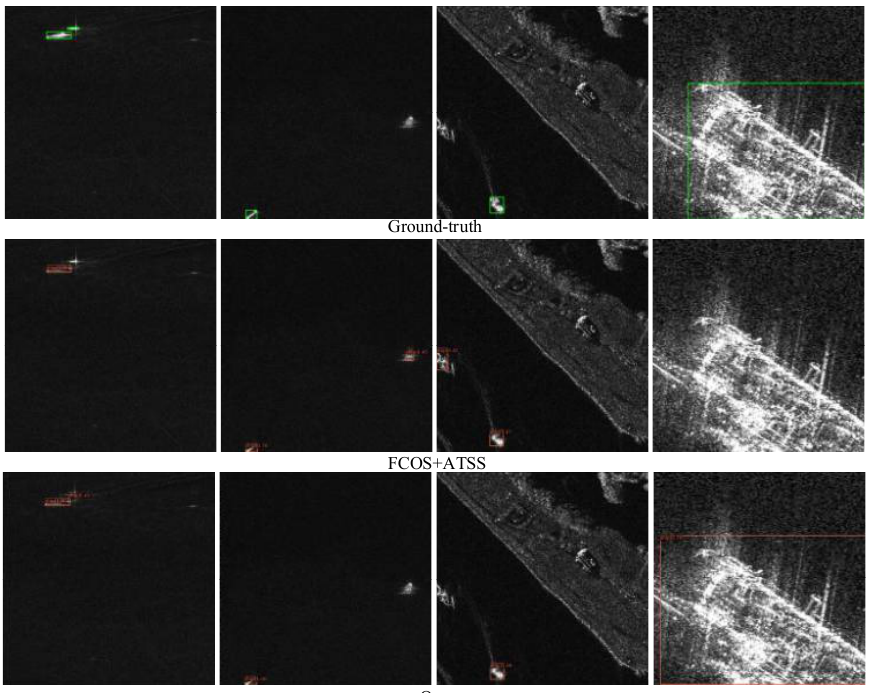
Figure 7. Comparison results of FCOS + ATSS and the proposed method on HRSID. The green rectangles indicate the ground-truth, and the red rectangles indicate the detection results.